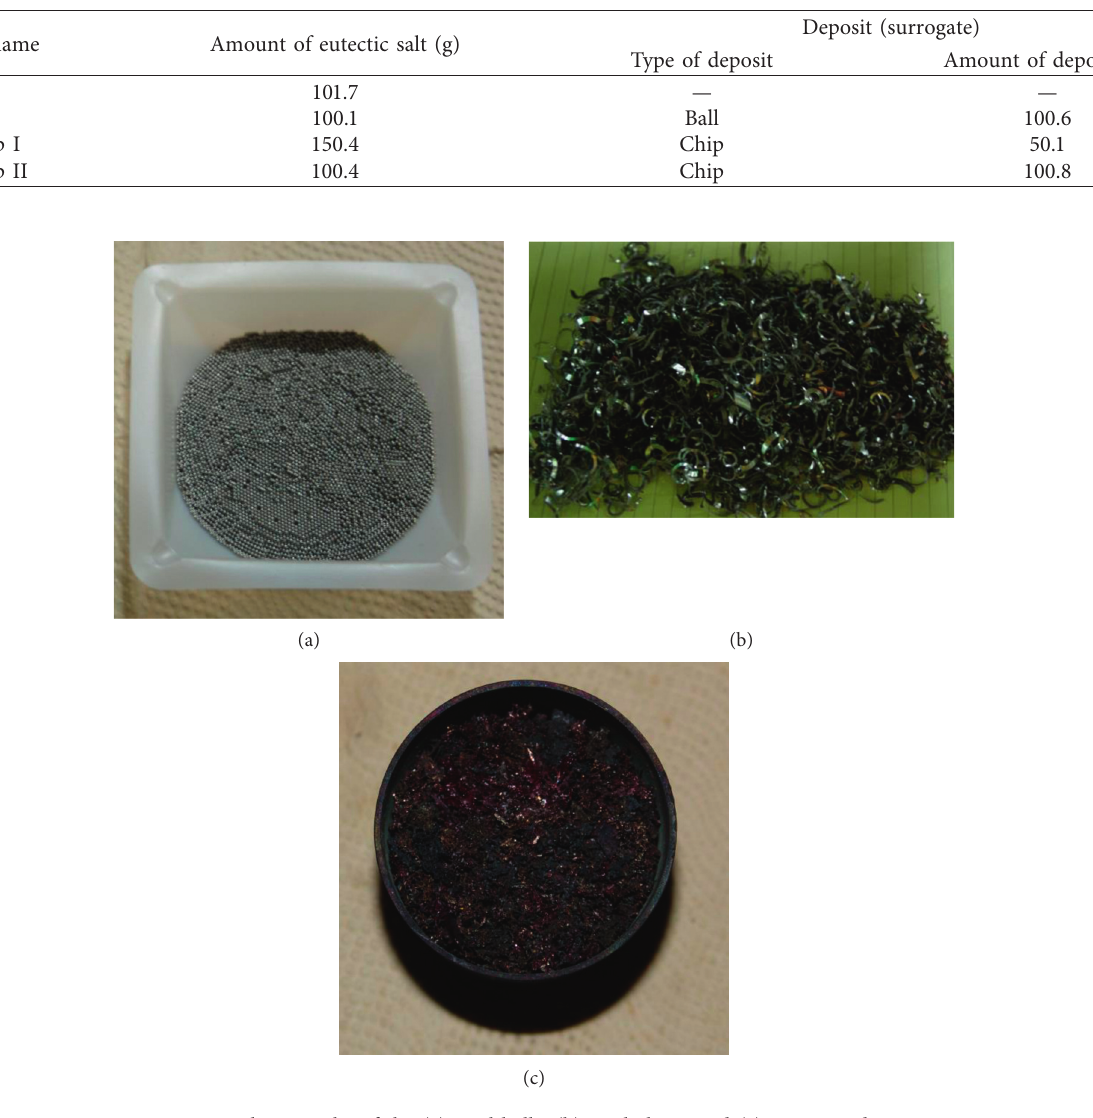
Figure 2: Photographs of the (a) steel balls, (b) steel chips, and (c) uranium